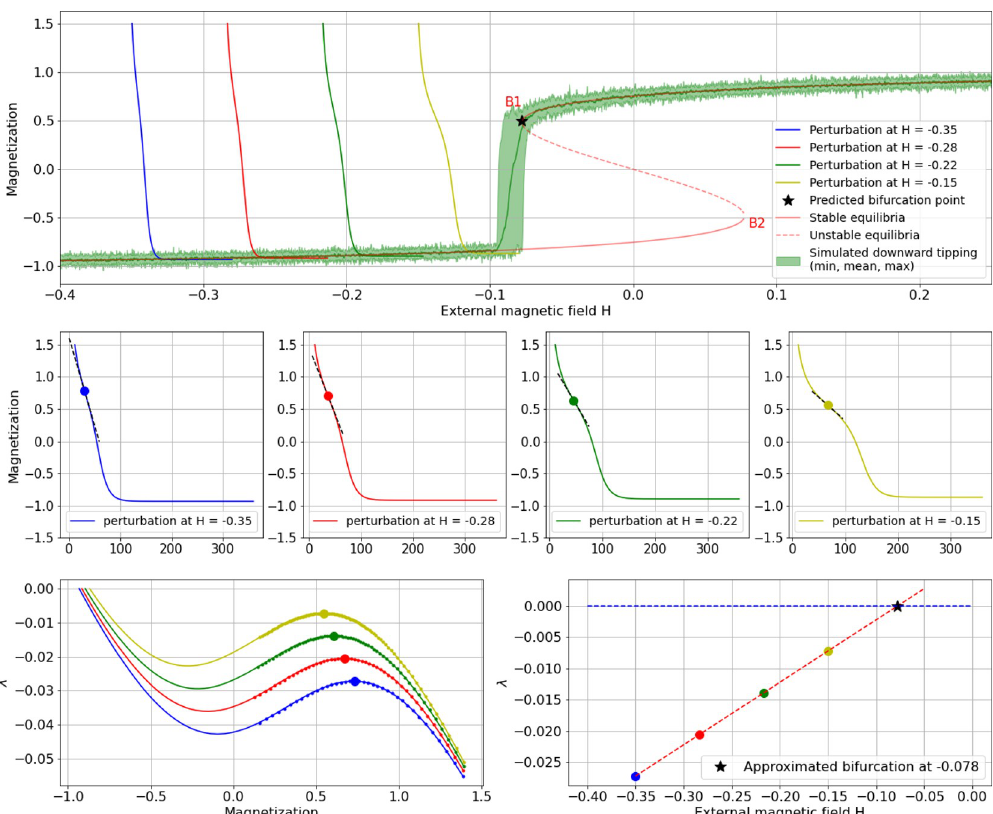
Fig 3. Visualization of transition prediction on EBM-Ising-model (Eq 2) showing hysteresis. Top-row plot) perturbations in relation to bifurcation (B1) with analytically derived equilibria (red); middle-row plots) recovery curves with slope indicated at differentiation maximum; left bottom-row plot) differentiated recovery curves with maxima indicated; right bottom-row plot) linear extrapolation of differentiation maxima against perturbance values. Note that in this realization the amplitude of perturbations is exaggerated for visualization purposes. An amplitude of 1.5 exceeds the depicted aggregate of magnetization, which indicates percentual spin orientation, and is only possible in this EBM-realization. polynomial fit (Fig 3 left bottom plot). Assuming a linear approach to the critical transition and depending on the distinctiveness of the deflection, the maxima of the fitted curves (the bold blue, red, green and yellow points in Fig 3 left bottom plot) can then be considered against the critical parameter values at which the system was perturbed (Fig 3 right bottom plot). Fitting the four points with linear regression and extending the resulting line (dotted red) to the zero-line (dotted blue) indicates the parameter value at which the slope (dotted black in Fig 3 middle-row plots) of a corresponding recovery curve would be horizontal, or in other words, at which no recovery would take place anymore. This point hence indicates the bifurca- tion point as indicated, in this case at H = -0.078 (Fig 3). Alternatively, a correlated sample of points from the fitted differentiation curves can be obtained, which when treated analogously in a linear extrapolation to the zero line, may provide an approximation of the equilibrium curve around the bifurcation point (see [4] for details, and results in Figs 4, 5 and 7). Theoretically, an analog procedure should allow to predict the second bifurcation (B2 in Fig 3 top-row plot) in a similar way, with perturbations applied to the lower equilibrium branch within the bi-stable region with amplitudes kept below the unstable equilibrium (see